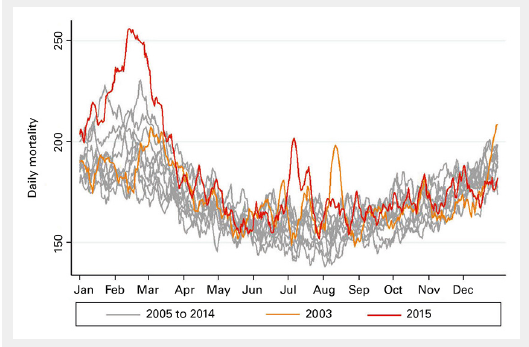
All-cause daily mortality (number of deaths) in Switzerland in 2003, from 2005 to 2014 and in 2015.